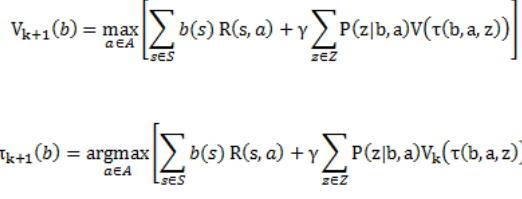
Figure 4. Value iteration calculates the value of each state by solving the Bellman equations.